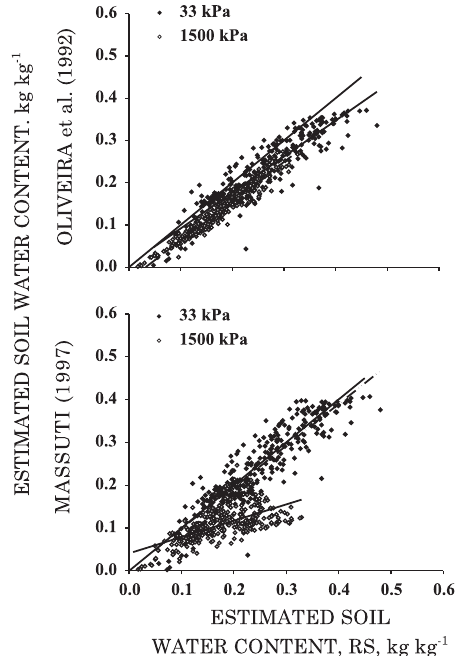
information.Figure 4. Relationship 1:1 between the gravimetric soil water content estimated by the proposed model ( θθθθθ ges) and that estimated by the model of Oliveira et al. (2002) ( θθθθθ gOl) and Masutti (1997) ( θθθθθ gMa), for the tensions of 33 and 1,500